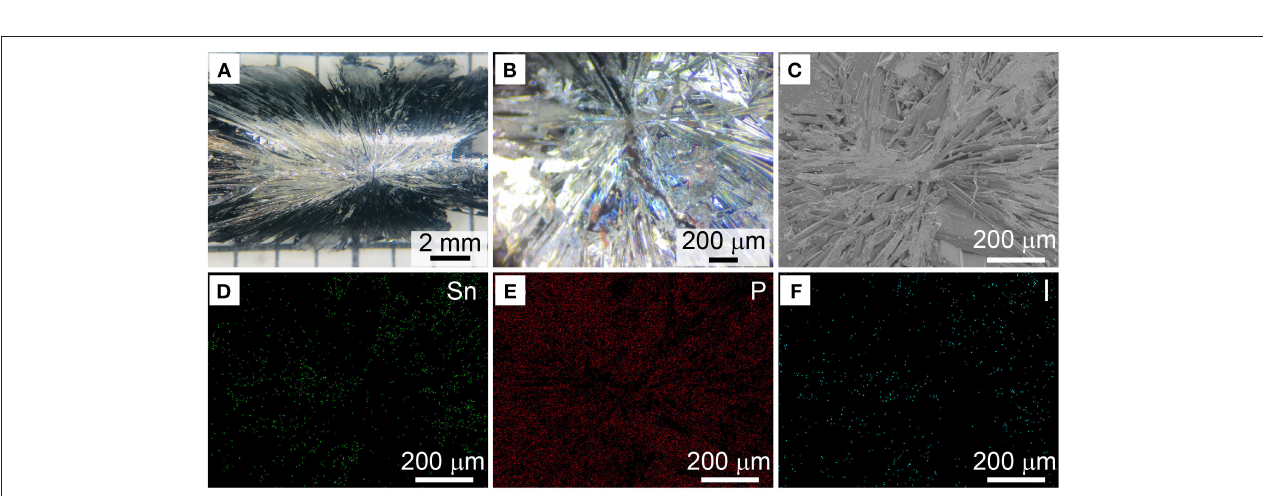
FIGURE 4 | (A) Representative photo of the as-obtained BP crystals with an intersection point. (B) Corresponding enlarged photo of the intersection point. (C) SEM image of a randomly selected intersection point. (D–F) Corresponding elemental mapping of the intersection point shown in (C)